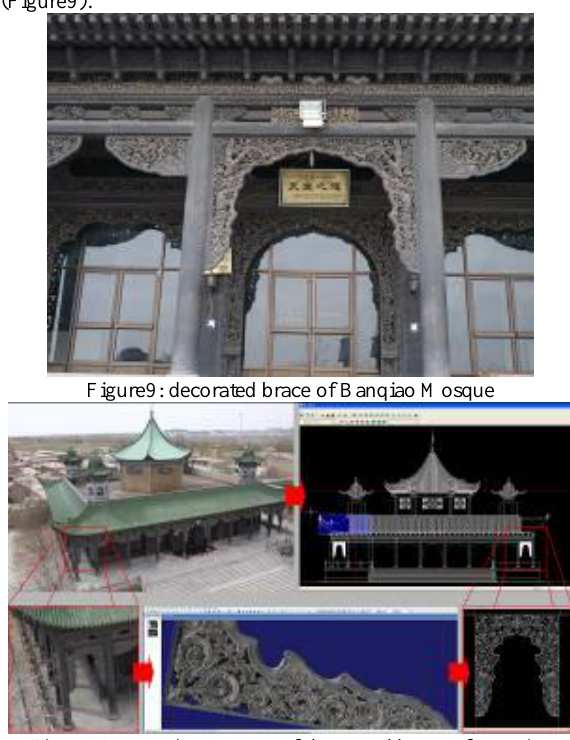
Figure10: mapping process of decorated brace of Banqiao Mosque